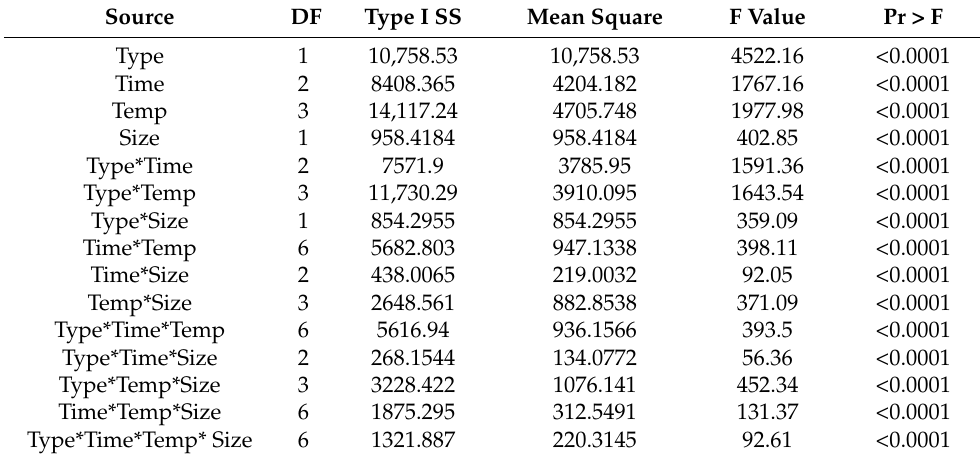
Table 4. ANOVA table of each effect for moisture content.